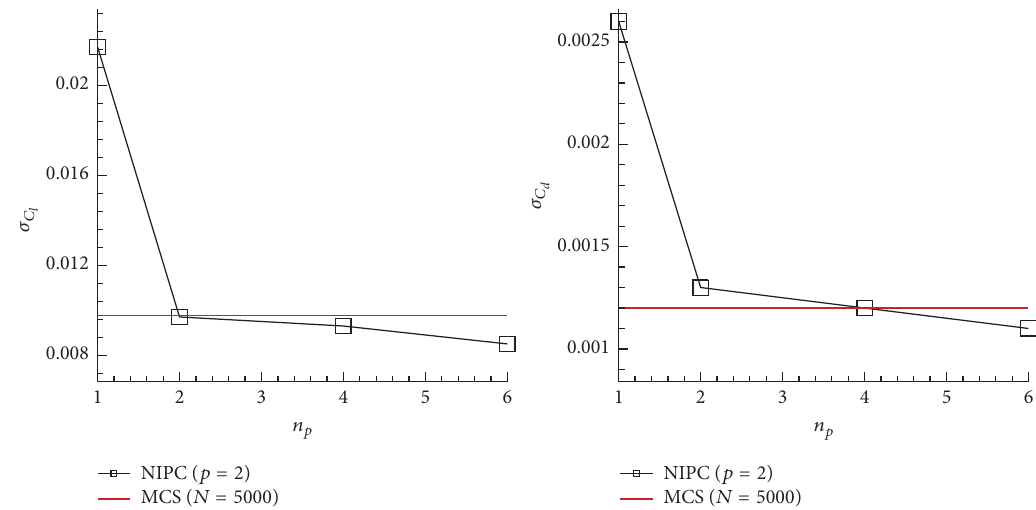
Figure 10: Standard deviation distribution of the aerodynamic coefficients oversampling ratio 𝑛 𝑝